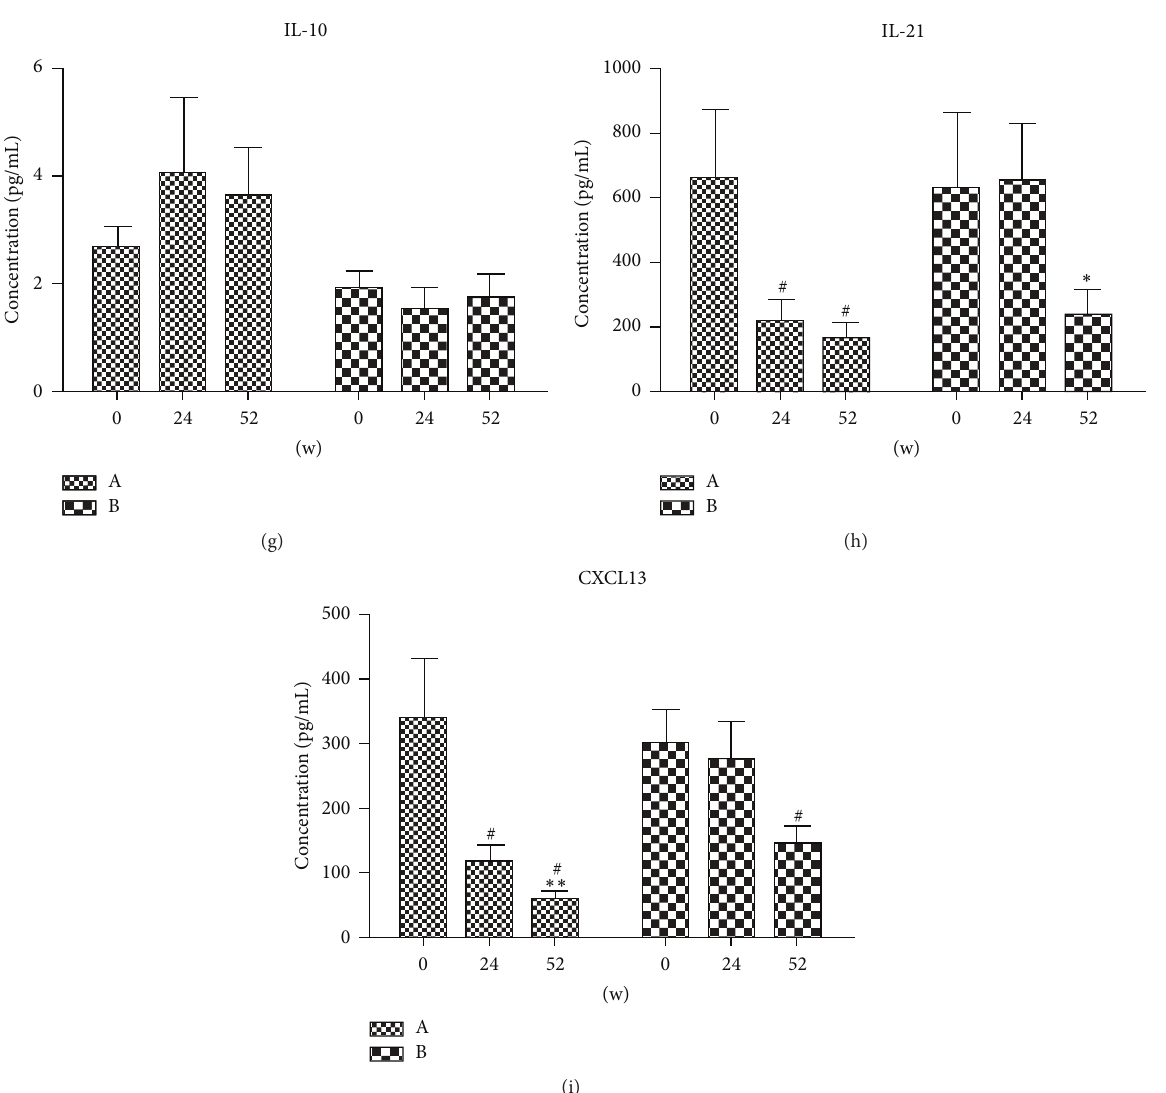
Figure 3: Changes of cytokines in serum of RA patients before and after therapy. Concentration (pg/mL) of (a) IFN- 𝛾 , (b) IL-18, (c) IL-6, (d) IL-4, (e) TNF- 𝛼 , (f) IL-17A, (g) IL-10, (h) IL-21, and (i) CXCL13. Mean concentrations of cytokines in serum of patients in our study were quantified by ELISA, and ∗ 𝑝 < 0.05 , ∗∗ 𝑝 < 0.01 , and ∗∗∗ 𝑝 < 0.001 are statistically significant compared to 24 w. # 𝑝 < 0.05 , ## 𝑝 < 0.01 , and ### 𝑝 < 0.001 are statistically significant compared to 0w. Group A: iguratimod was administered to patients for 52 weeks. Group B: placebo was administered to patients for the first 24 weeks and iguratimod was administered to patients for the subsequent 28 weeks.